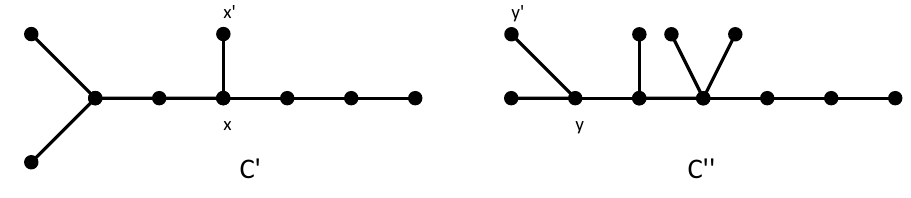
Figure 10: The two caterpillars 𝐶 ′ and 𝐶 ′′